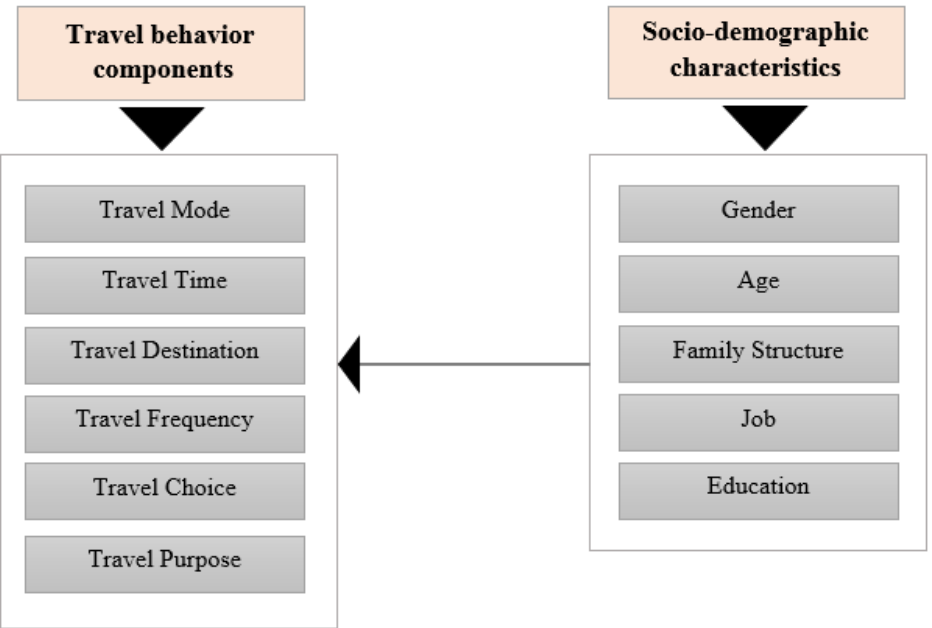
Figure 2. Conceptual models of the study variables. Table 1. Socio-demographic characteristics of the